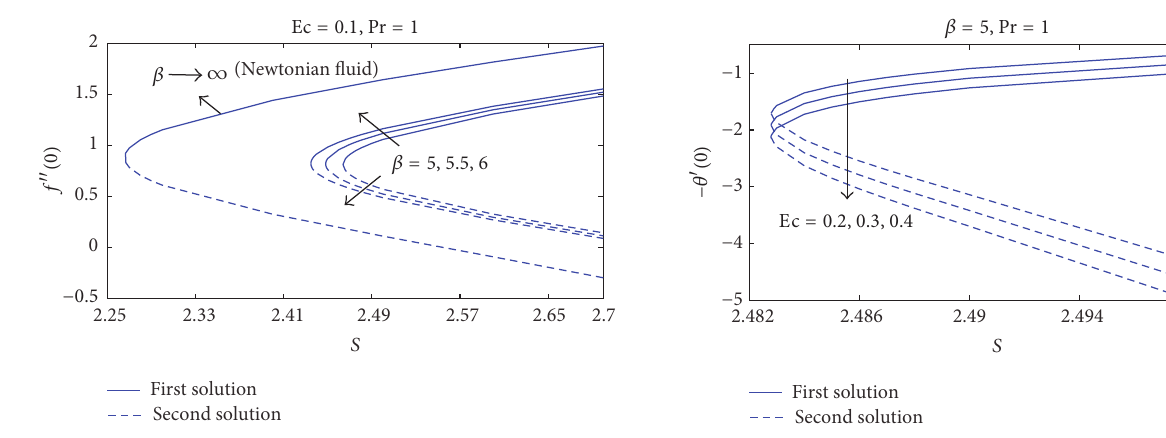
Figure 4: Heat transfer coefficient −𝜃 󸀠 (0) with 𝑆 for different values of